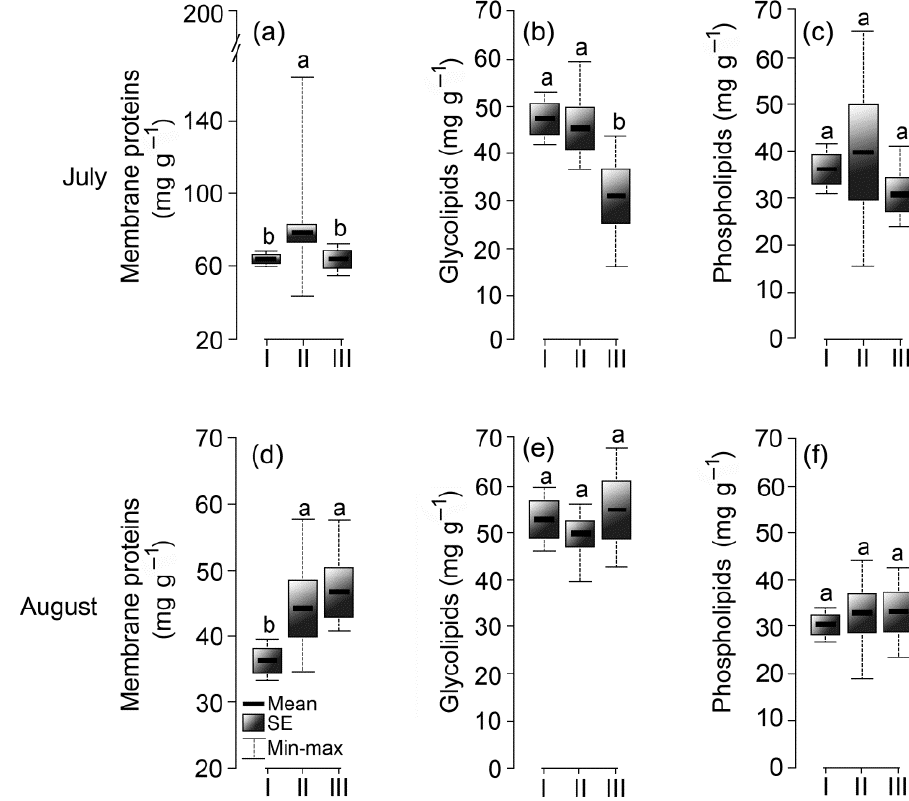
Figure 5. The content of MP (July—( a ), August—( d )), GL (July—( b ), August—( e )) and PL (July—( c ), August—( f )) in the potato leaves depending on the ripening degree and the growing season. I—early variety; II—medium-early variety; III—mid-season.